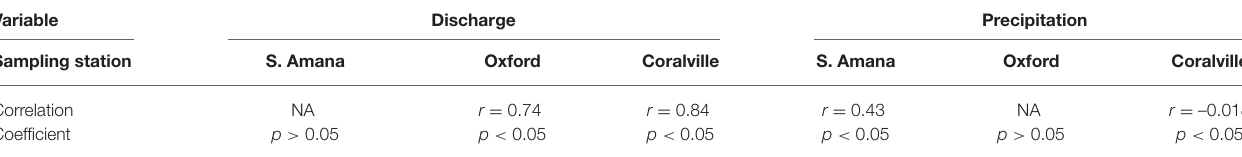
TABLE 5 | Correlation coefficients between hydrologic variables and POC concentrations. Variable